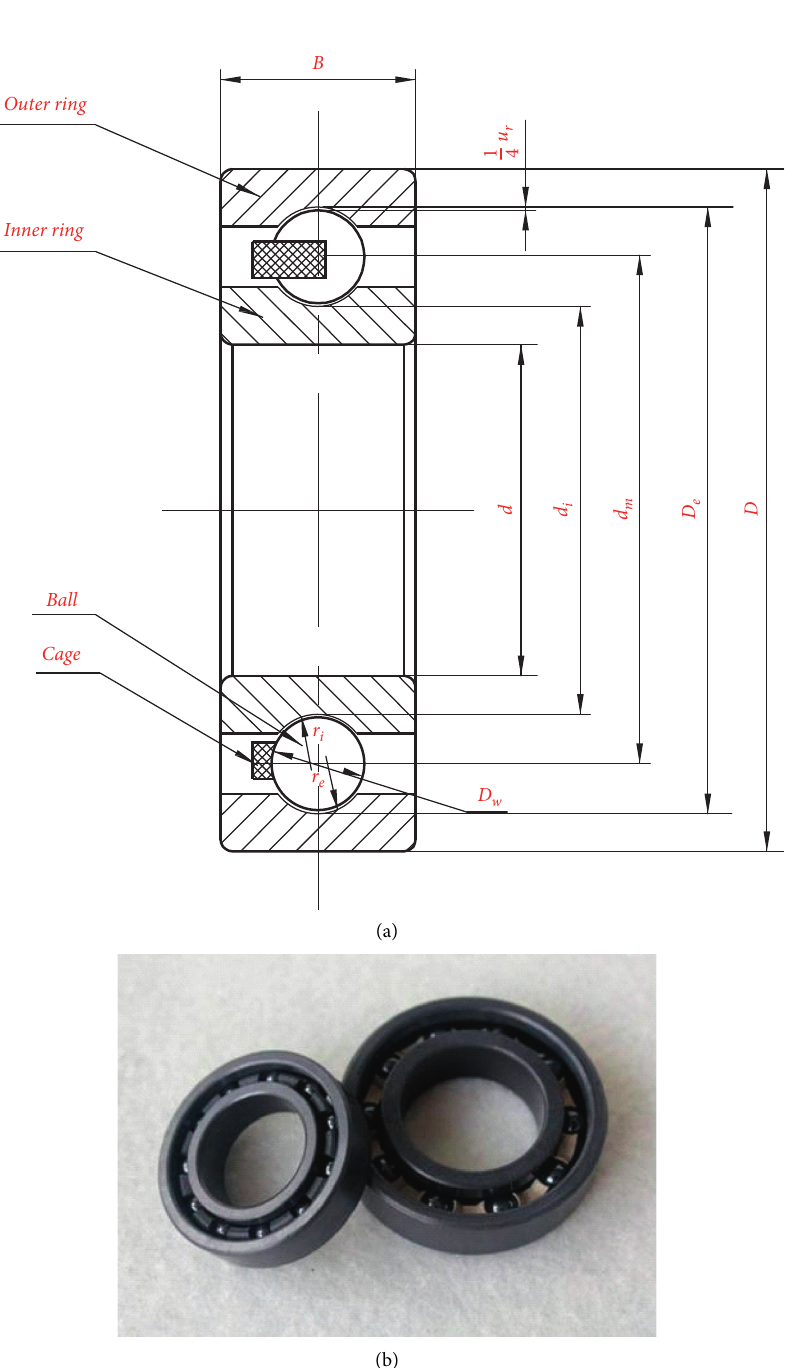
Figure 2: Structure and samples of full-ceramic bearings. (a) Structure of 6206 full-ceramic bearing. (b) Samples of Si